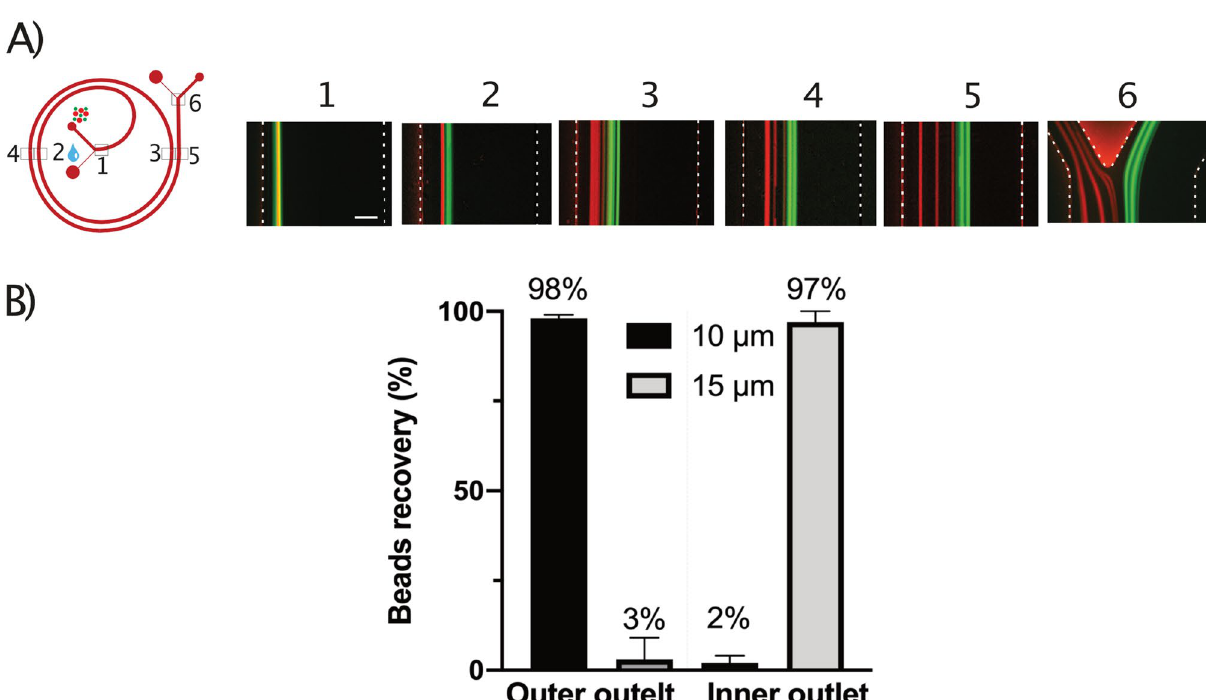
Figure 7. Sheath-based flow for particle separation. ( A ) Differential migration of 10 µm (green) 15 µm particles (red) from the inner wall. Particle position at the different regions (position 1–6) are shown, clearly indicating that the smaller 10 µm particles migrate first towards the outer wall. ( B ) Particle counting results, indicating high separation efficiency where 98% of 10 µm particles were collected at outer outlet and 97% of 15 µm particles at the inner outlet. The total flow rate was 1 mL/min (sheath: 950 µL/min and sample: 50